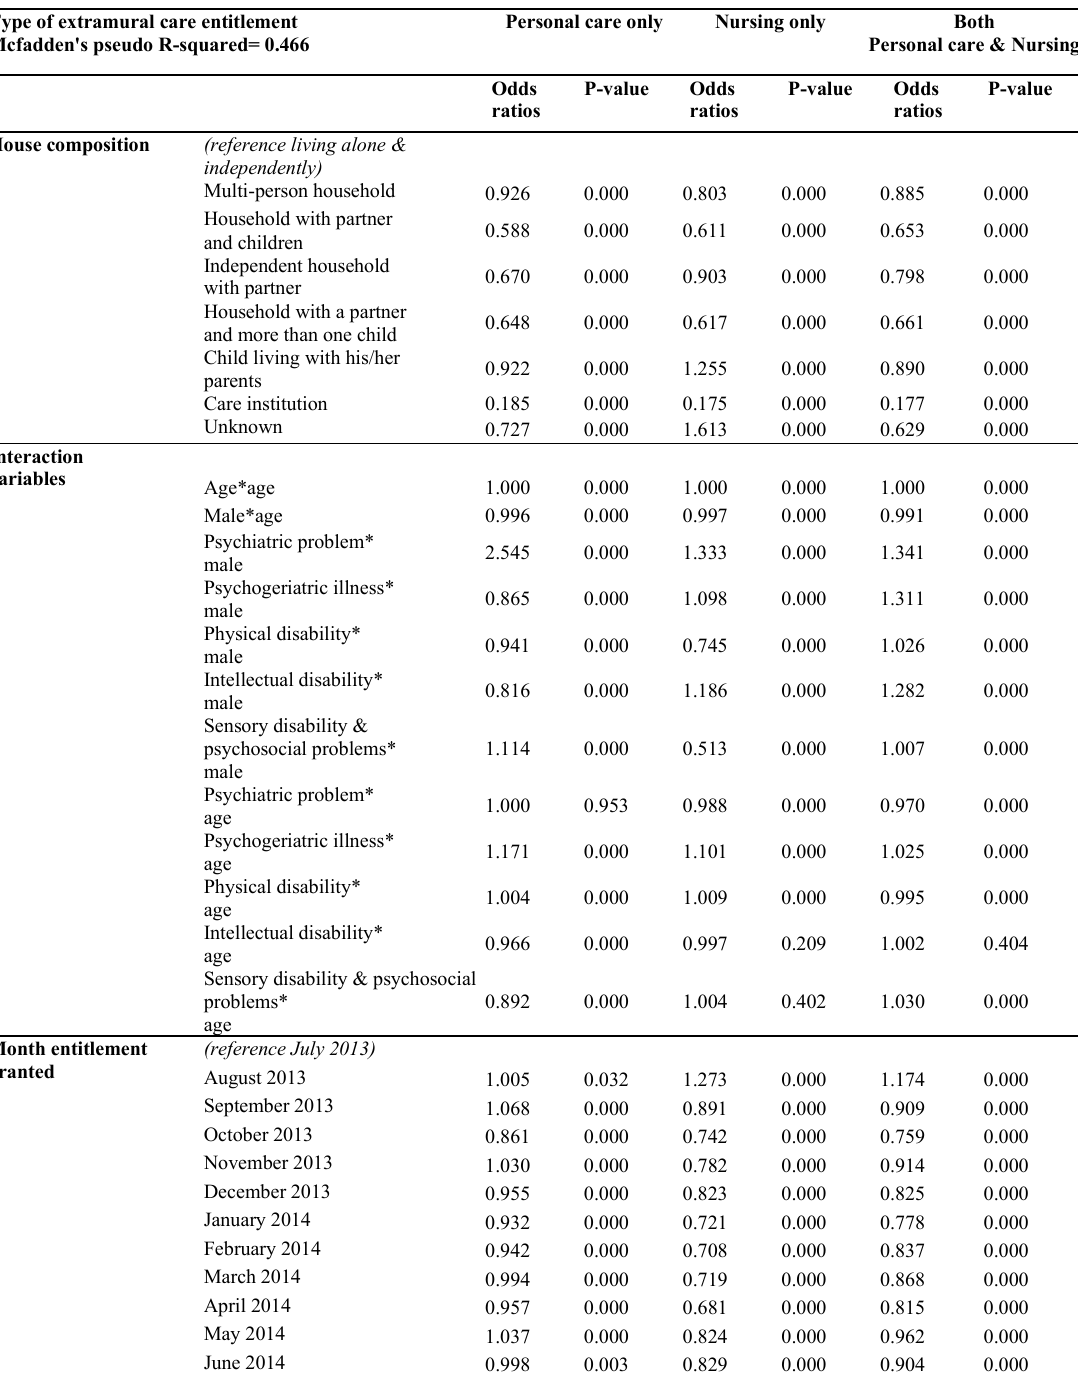
Table 3.2: Model 1 multinomial logistic model for the probability of an home care entitlement younger than 65